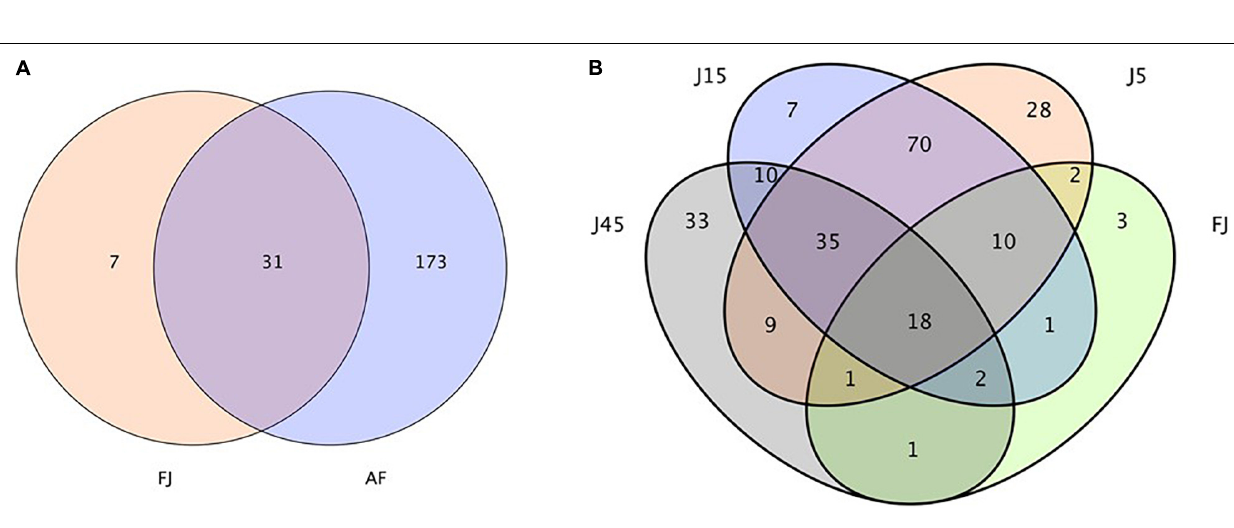
Frontiers in Microbiology |